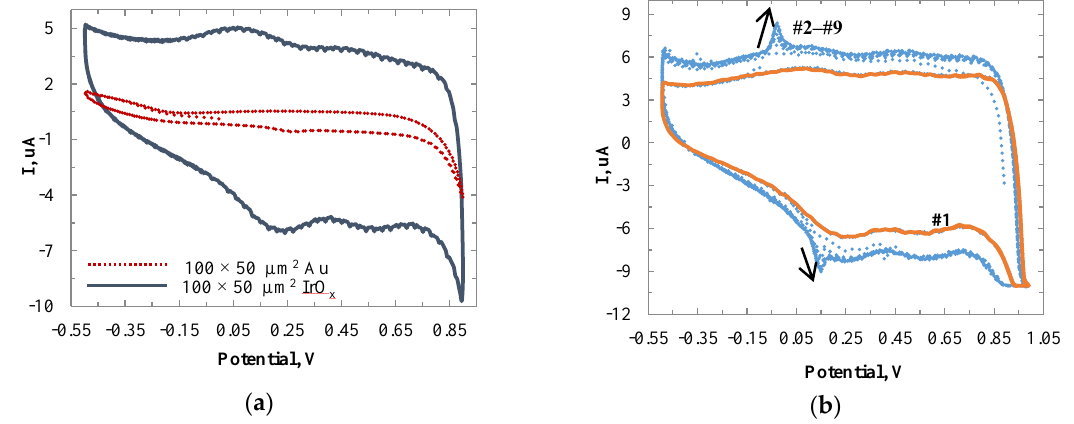
Figure 4. ( a ) CV plots of an Au electrode and IrO x modified electrode with a size of 100 × 50 μm in PBS at 300 mV/s. ( b ) CV plots of the IrO x electrode in PBS at 300 mV/s. Curve #1 was the CV curve before the adding of lactate. Curves #2‒#9 were the respective results after eight successive additions of lactate.